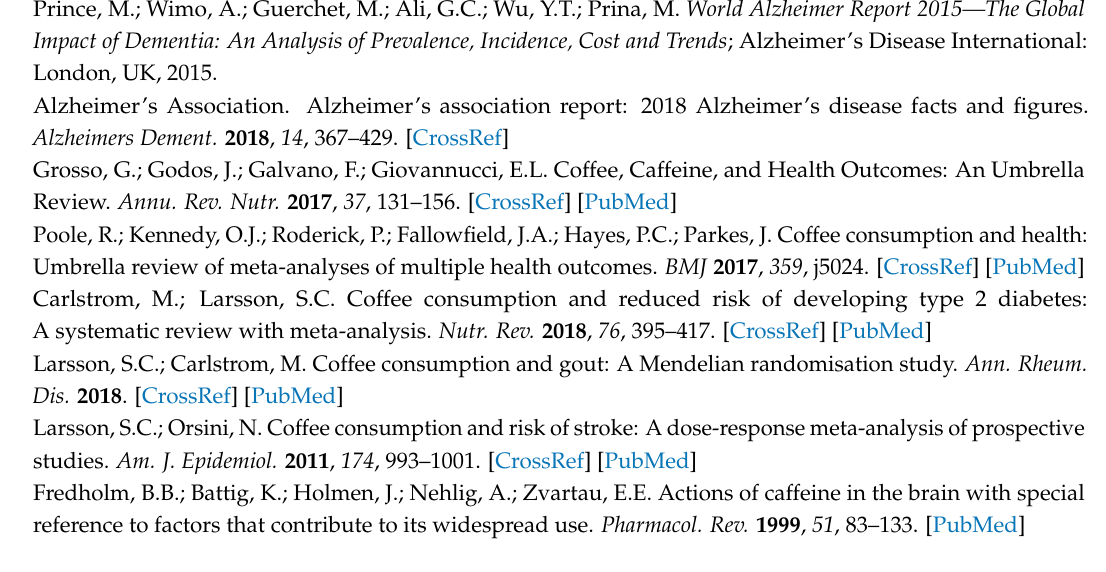
s1, Figure S1: Newcastle-Ottawa Scale: Details of how the criteria were applied; Figure S2: Funnel plot to visually assess publication bias. Egger’s test: p =